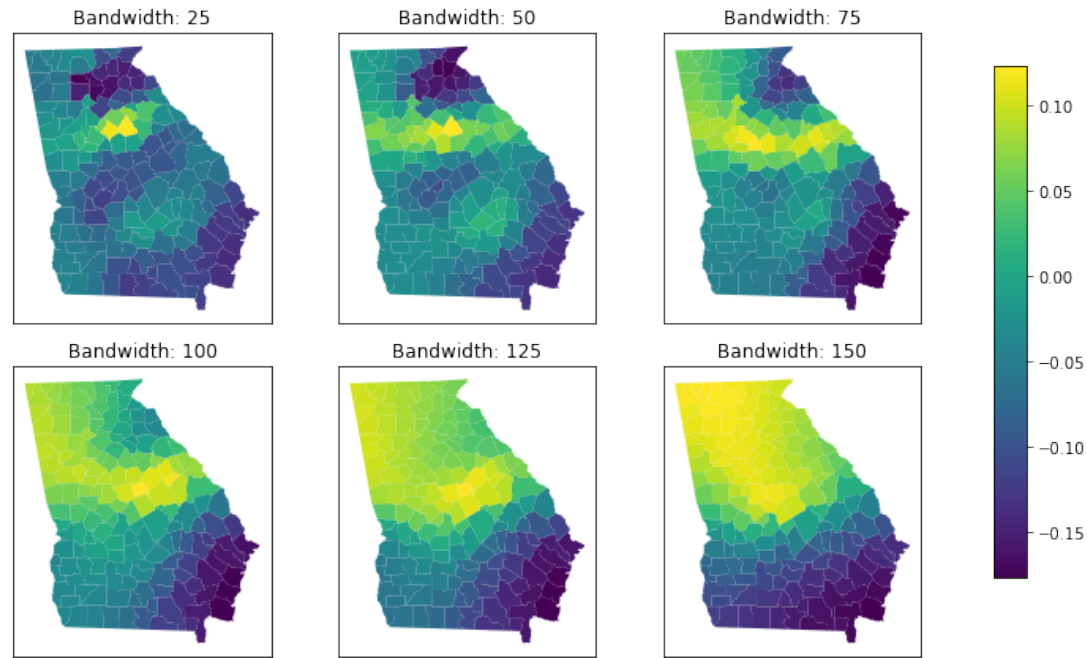
Figure 5. Spatial heterogeneity of the percent rural parameter surface for the Georgia dataset using different